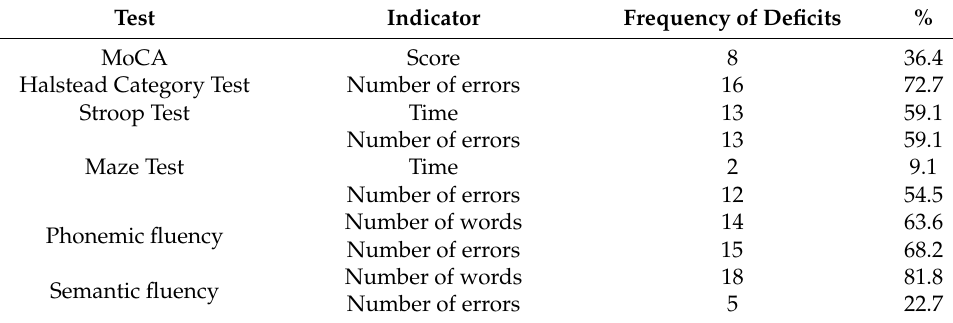
Table 2. Frequency of deficits identified in the specific